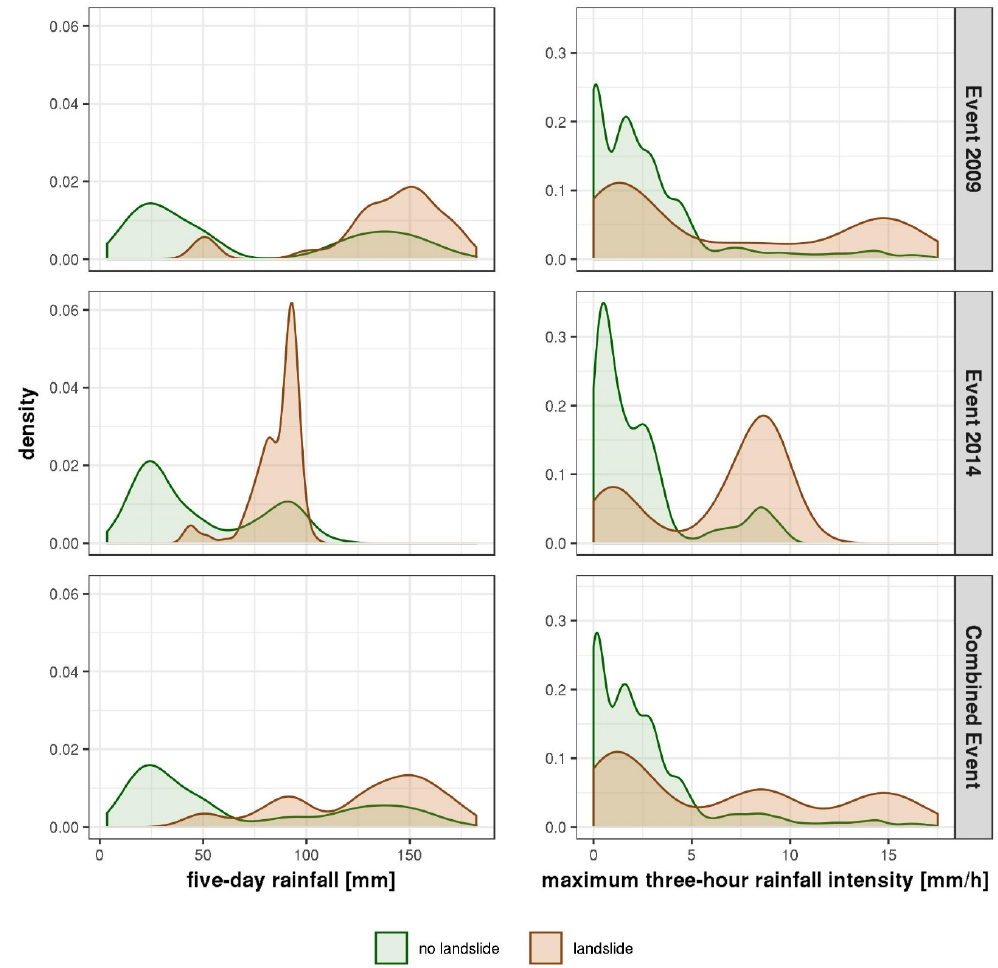
Figure A2. Density plots showing the distribution of meteorological variables dependent on the event data, grouped by landslide and non-landslide occurrences.